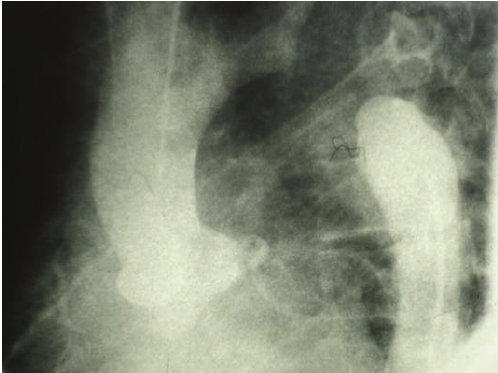
Figure 2: LV angiogram.